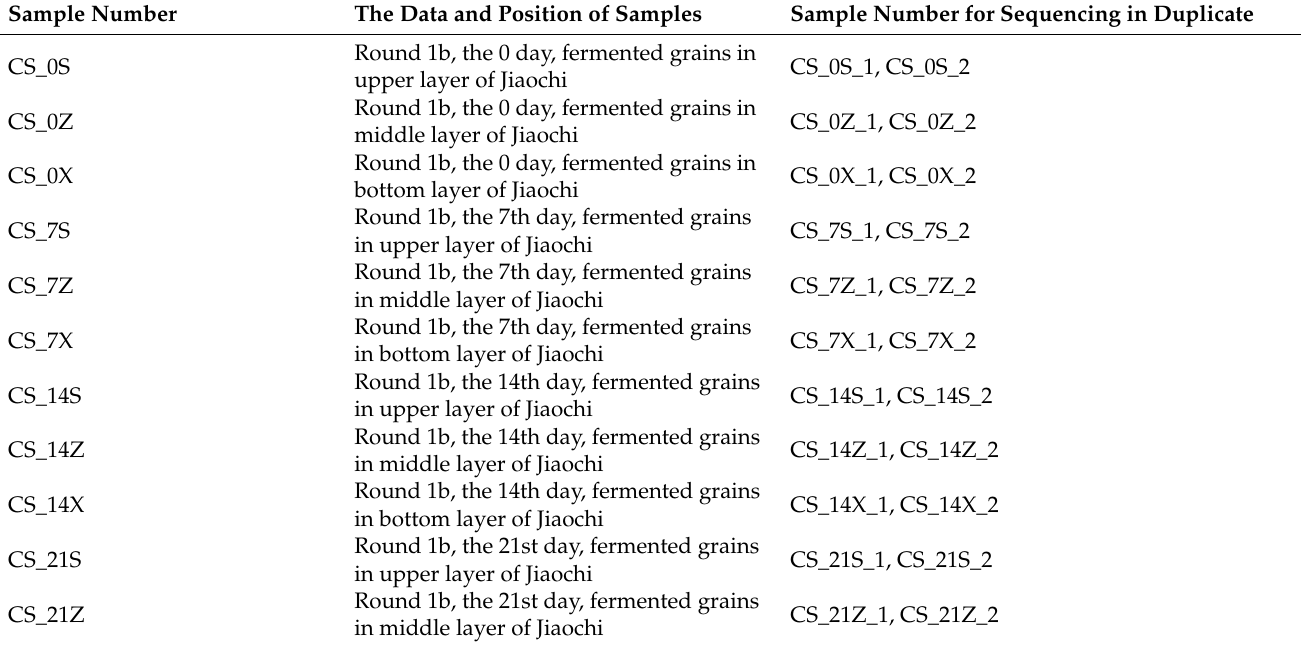
Table 1. Abbreviation and detail information of samples used for sequencing. The Data and Position of Samples Sample Number for Sequencing in